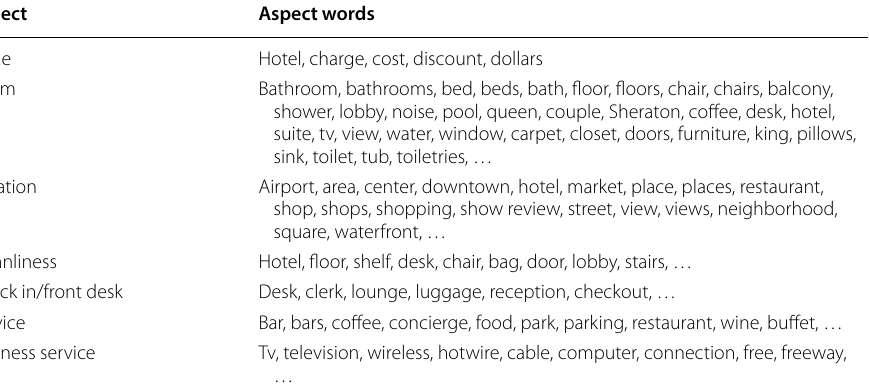
Table 8 Aspect word set of Hotel data